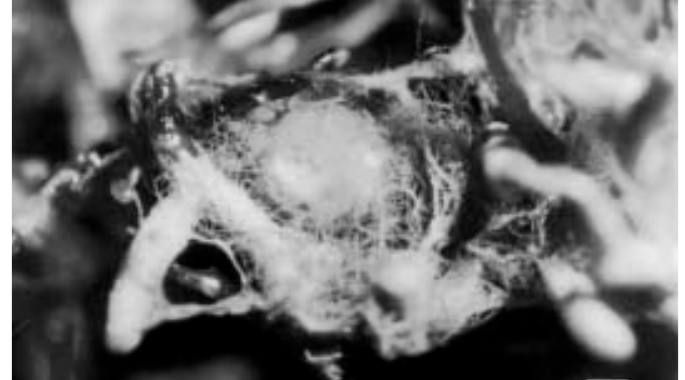
Figure 1. Scletrotium formed in the rhizosphere of Eucalyptus grandis seedling inoculated with the isolate PT 306 (94R) of Pisolithus sp. Scale bar = 200